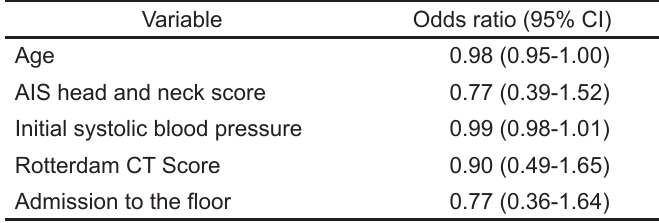
Table 4a. Adjusted analysis for predicting outcome measures.**